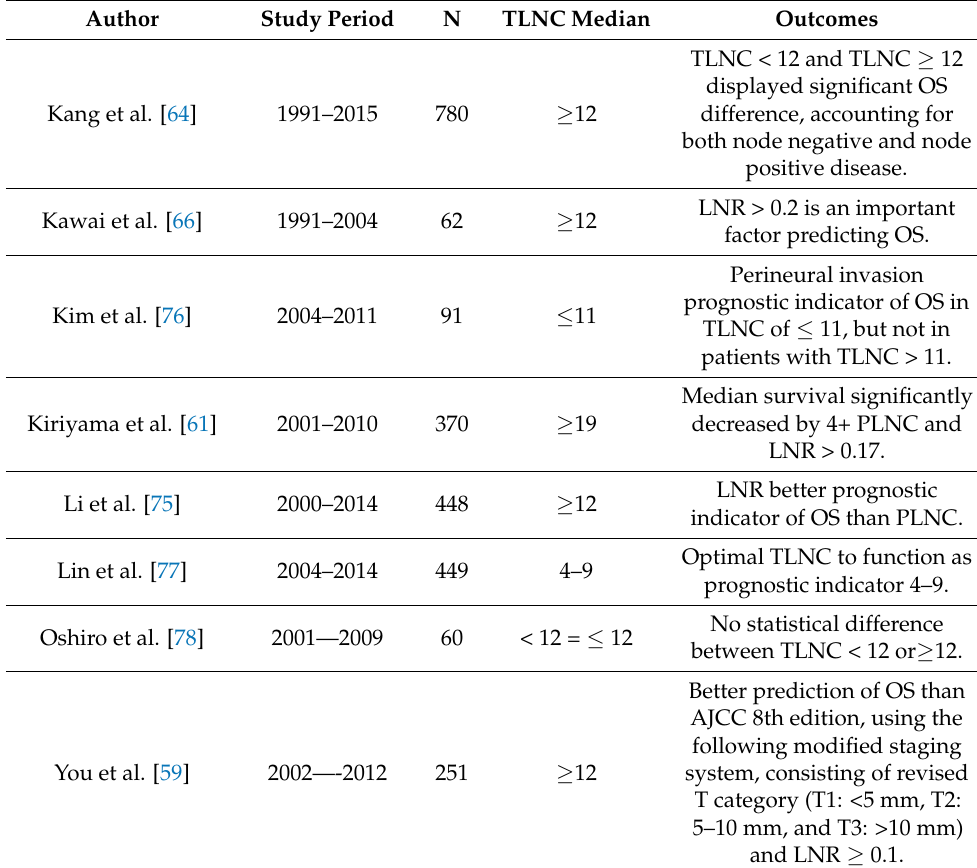
Table 4. Selected references evaluating lymph node